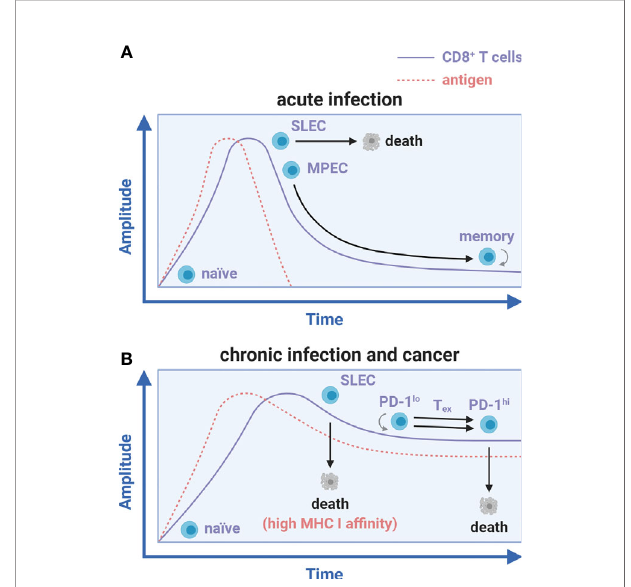
FIGURE 1 | Antigen load differentially in fl uences CD8 + T cell memory and exhaustion fates. CD8 + T cell differentiation during acute infection versus chronic infection and cancer. (A) Activation of naïve CD8 + T cells during acute infection leads to SLEC and MPEC differentiation. Upon antigen clearance, SLECs undergo apoptosis while MPECs survive and differentiate into long- lived, self-renewing memory CD8 + T cells. (B) With chronic infection and cancer, SLEC speci fi c to peptides of high MHC I af fi nity develop and prematurely die while the MPEC subset does not form. Instead of memory formation, CD8 + T cells against peptides of low MHC I af fi nity expand, exhaust (in a unidirectional PD-1 lo to PD-1 hi transition), and die in a continued stalemate against persistent